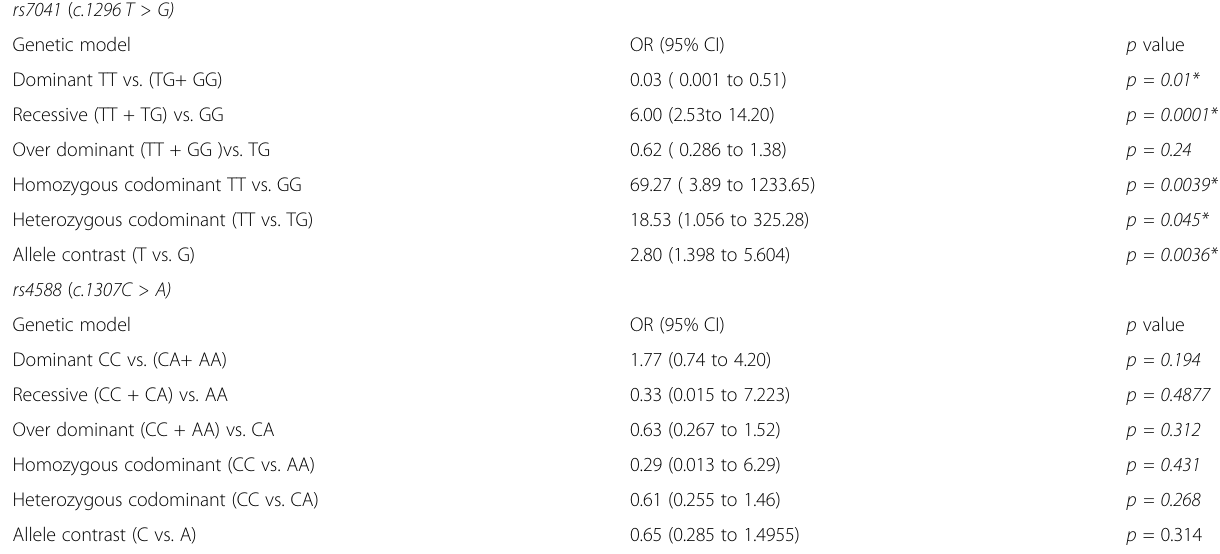
Table 3 Association analysis results for rs7041 and rs4588 genotypes under different genetic models rs7041 ( c.1296 T >